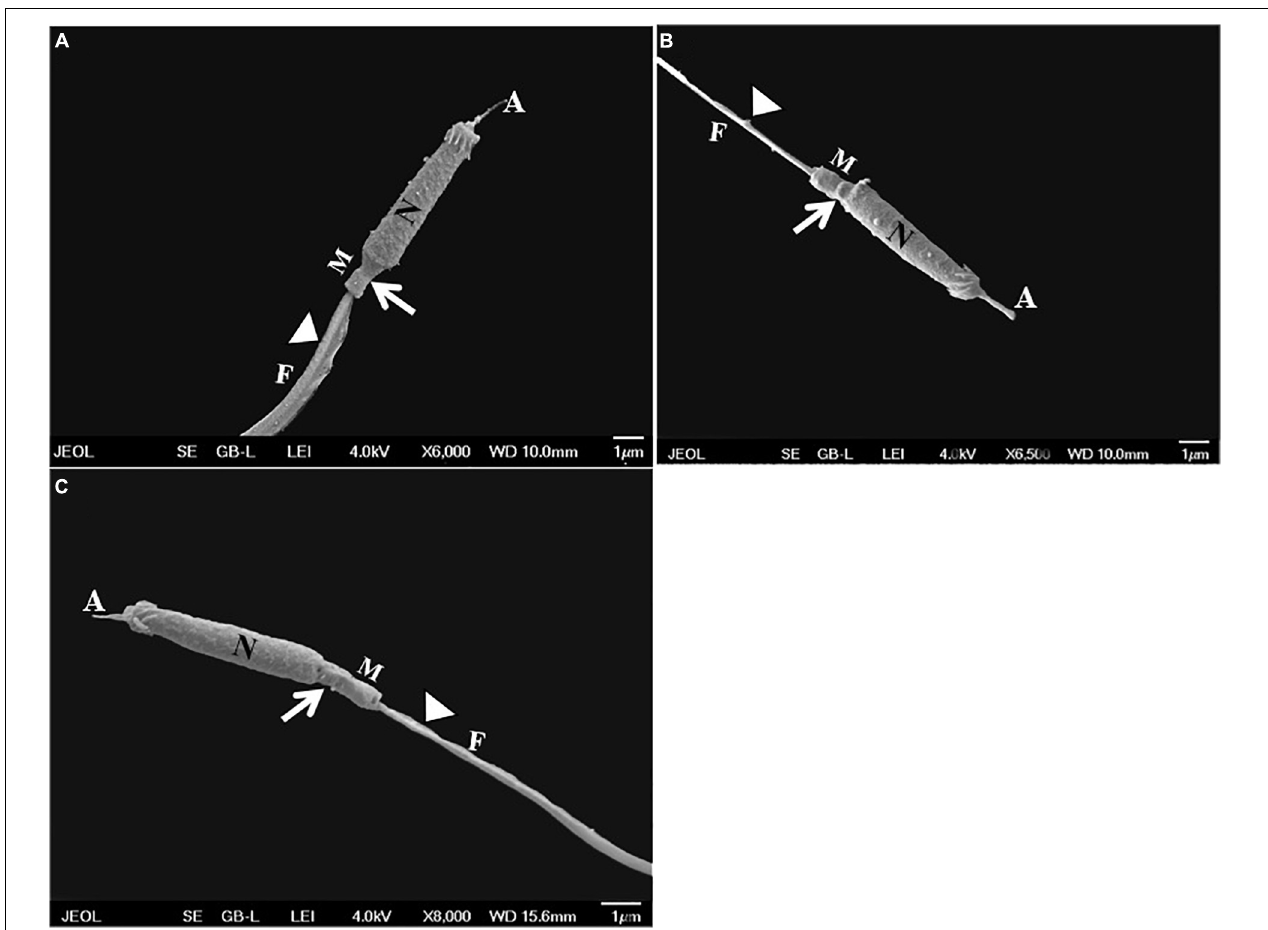
FIGURE 6 | Scanning electron micrographs showing the ultrastructure of sterlet spermatozoa in: (A) fresh spermatozoa without damage in the ultrastructure; (B) cryopreserved spermatozoa without supplementation of 10 µ g/mL AFPI showing swollen midpiece (white arrows), and ruptured and detached flagellum (white arrowheads); and (C) cryopreserved spermatozoa with supplementation of 10 µ g/mL AFPI showing swollen midpiece (white arrows) and detached flagellum (white arrowheads). A, acrosome; N, nucleus; M, mitochondria; F,